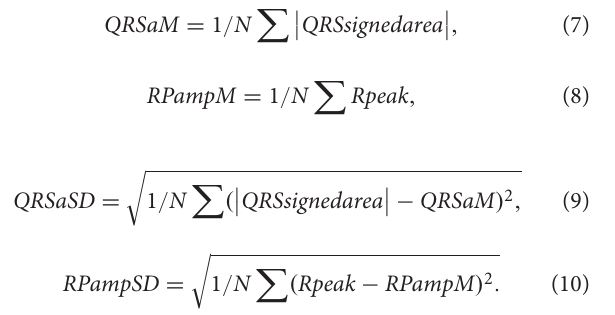
(PSD) of the bands using Welch’s periodogram with a Hanning window (window size: 256 points with an overlap of